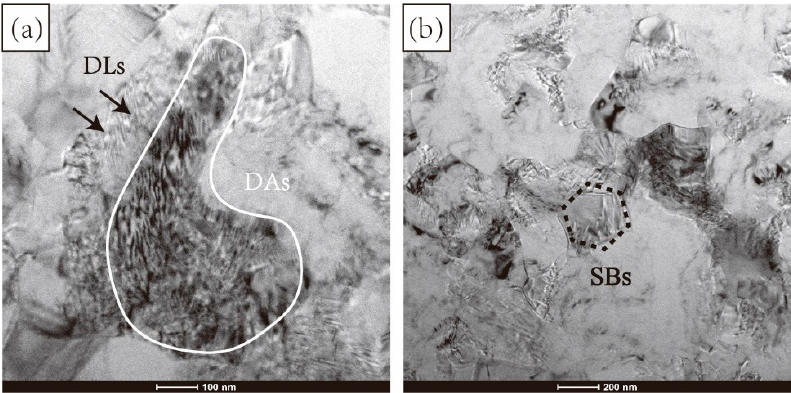
Figure 13. Evolution of dislocation configuration of TC4 alloy after MDIF: ( a ) one cycle; ( b ) four cycles.